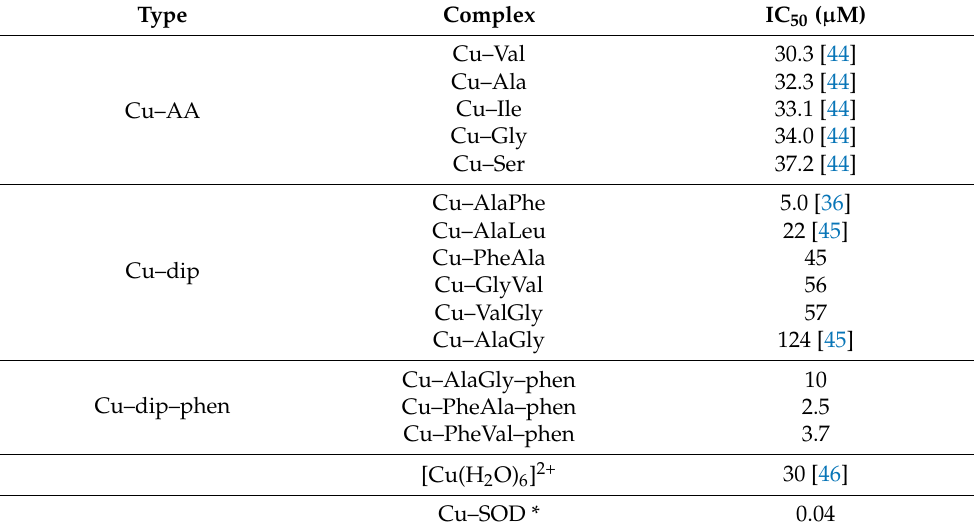
Table 2. Concentration required to yield 50% inhibition of the NBT reduction (IC 50 ). Boxplots of the IC 50 for each group of complexes are also